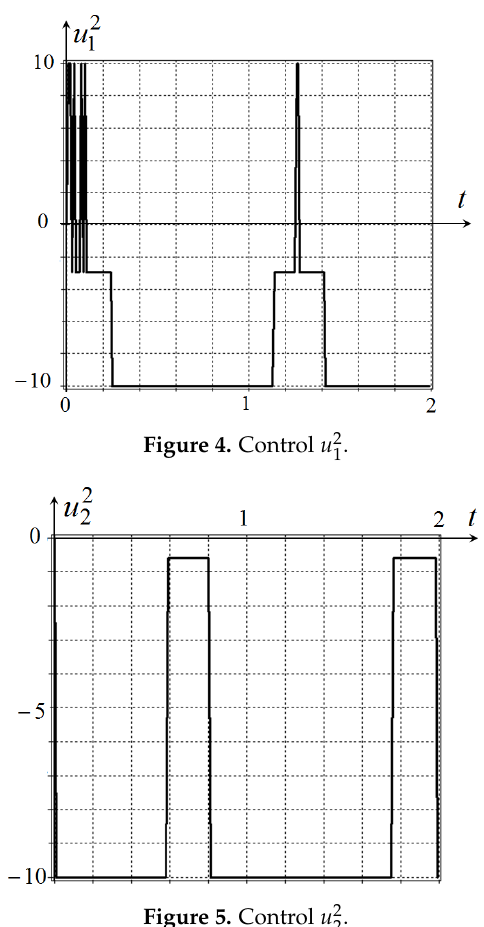
Figure 4. Control u 2